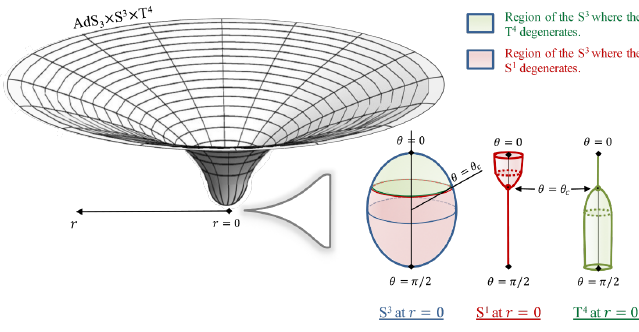
Figure 5 . Schematic description of the spacetime induced by a chain of two rods, inducing the degeneracy of the S 1 ( y ) and a T 4 direction ( x ). On the left-hand side, we depict the overall 1 geometry in terms of the radius r . On the right-hand side, we describe the behavior of the S 3 , S 1 , and T 4 at r = 0 and as a function of θ , giving the position on the S 3 . At r = 0 , the spacetime ends smoothly as a coordinate degeneracy of either the S 1 or the T 4 depending on the position on the S 3